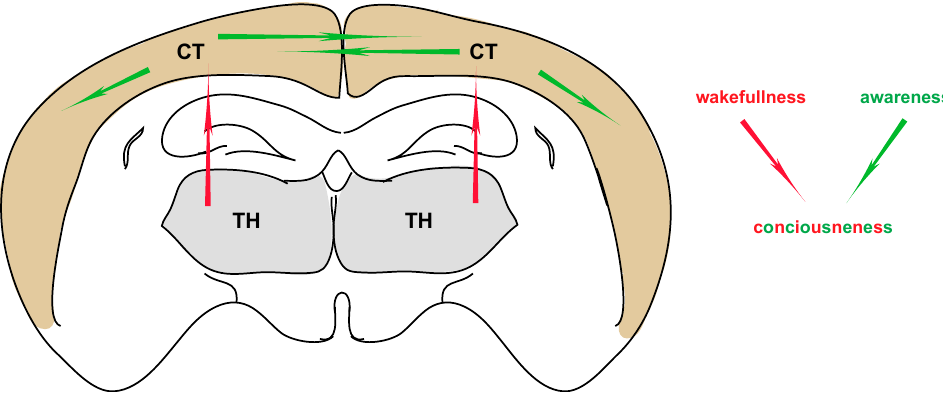
Figure 1. The basic parameters of consciousness. Corticocortical interactions are generally thought to contribute to the aspect of awareness, whereas thalamocortical interactions contribute to the aspect of wakefulness. Both are necessary for manifesting a “normal” state of consciousness. TH: thalamus, CT: cortex.